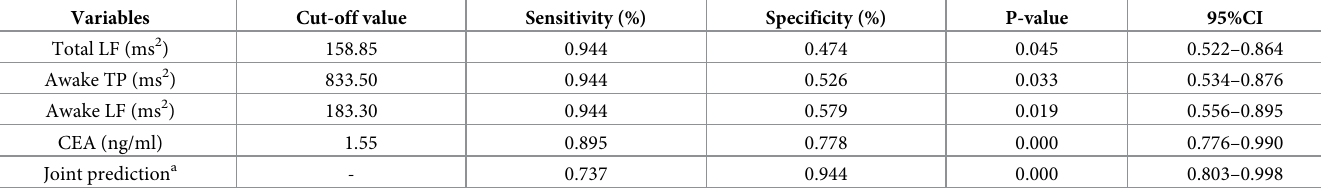
Table 3. Diagnostic efficacy of HRV parameters, CEA, and combined prediction for breast cancer.